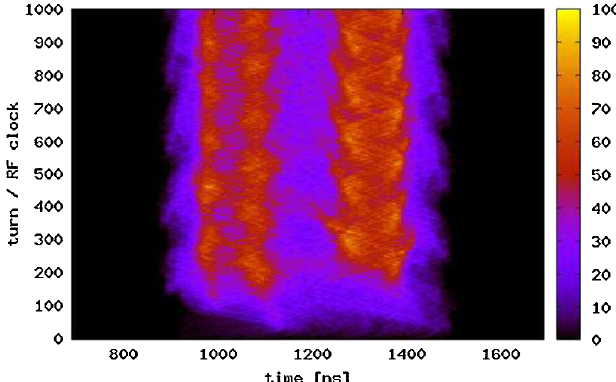
FIG. 7. (Color) Mountain plots of the simulated beam, second harmonic 80%, momentum offset of (cid:1) 0 : 2% , and phase sweep of 60 degrees.